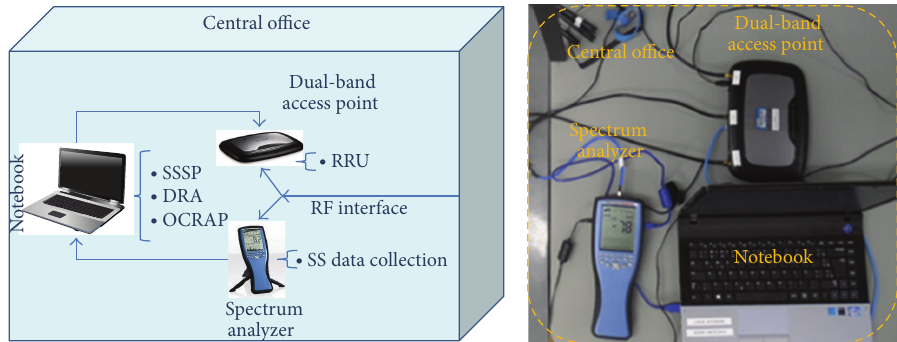
Figure 4: Components and functionalities of the central office.